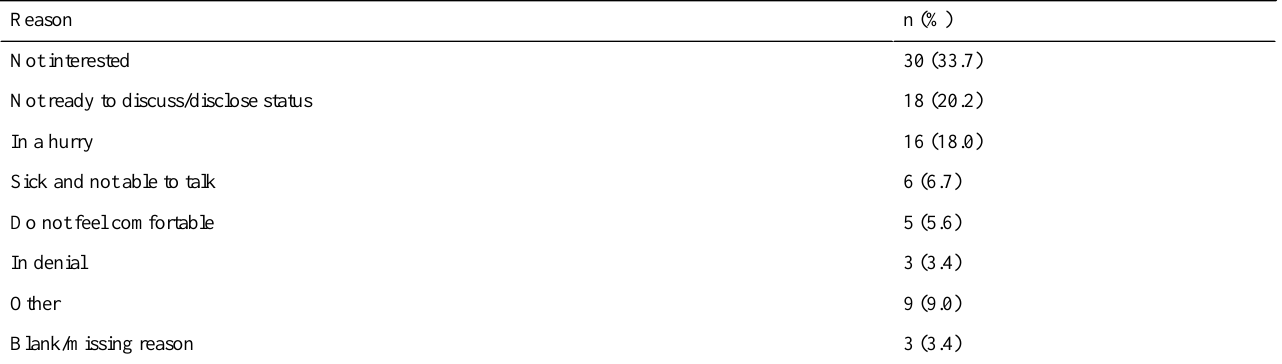
Table 2. Reasons for initial refusal to enrol in study (N=90).